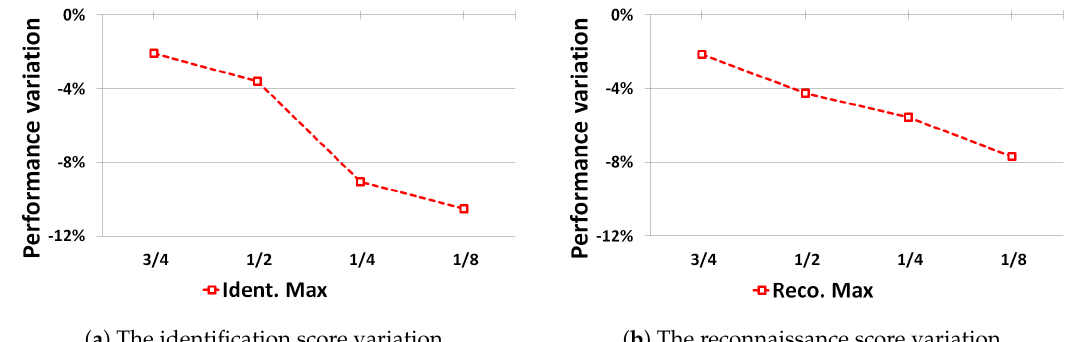
Figure 8. The influence of the dataset TRS3 size used during training on the best identification and reconnaissance results on the